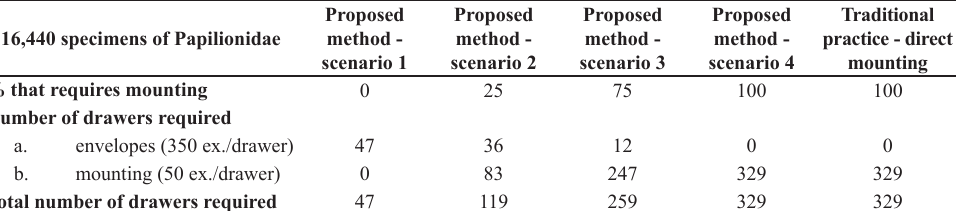
Table 2. Drawers required to store 16,440 specimens of Papilionidae in four scenarios, compared to the tradi - tional practice of direct mounting. Scenario 1 corresponds with the results of the 2016